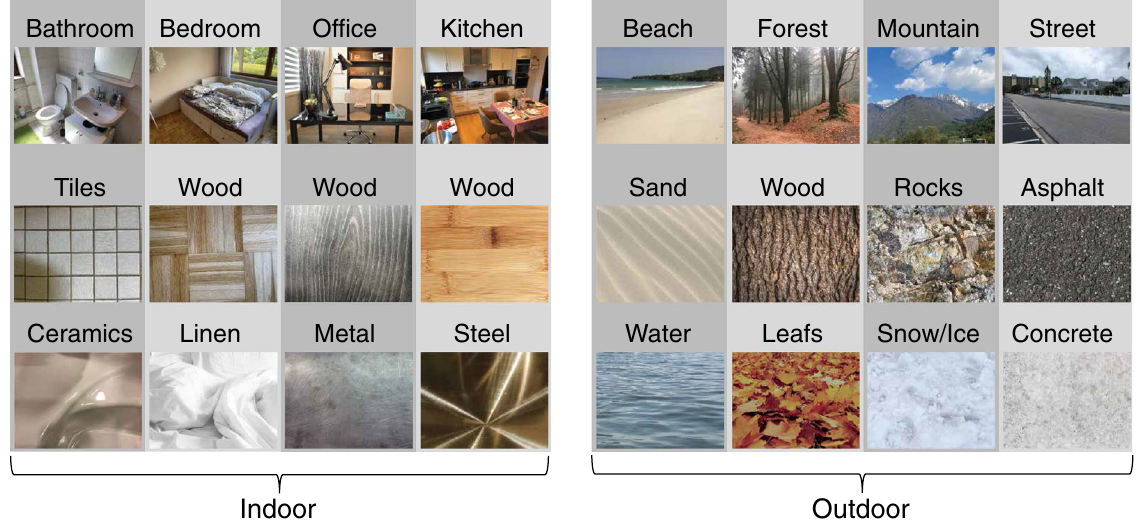
Figure 4. Scene and material categories that were used in the experiments. Top row: example stimuli from the four indoor and outdoor scene categories. Middle and bottom row: example stimuli of the two dominant materials per scene